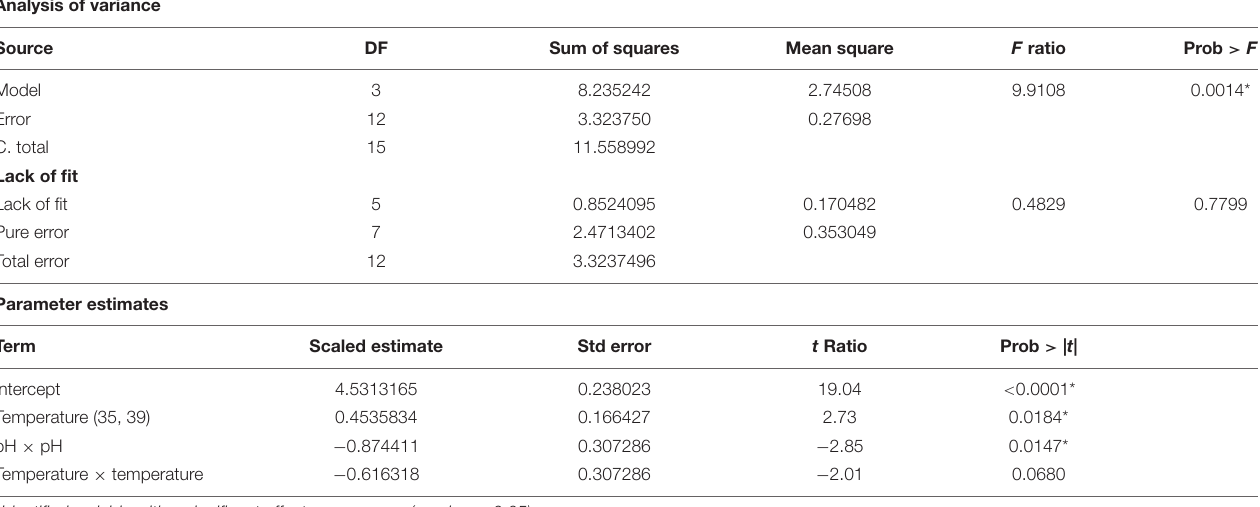
TABLE 5 | Regression analysis of predicted models for specific yield.